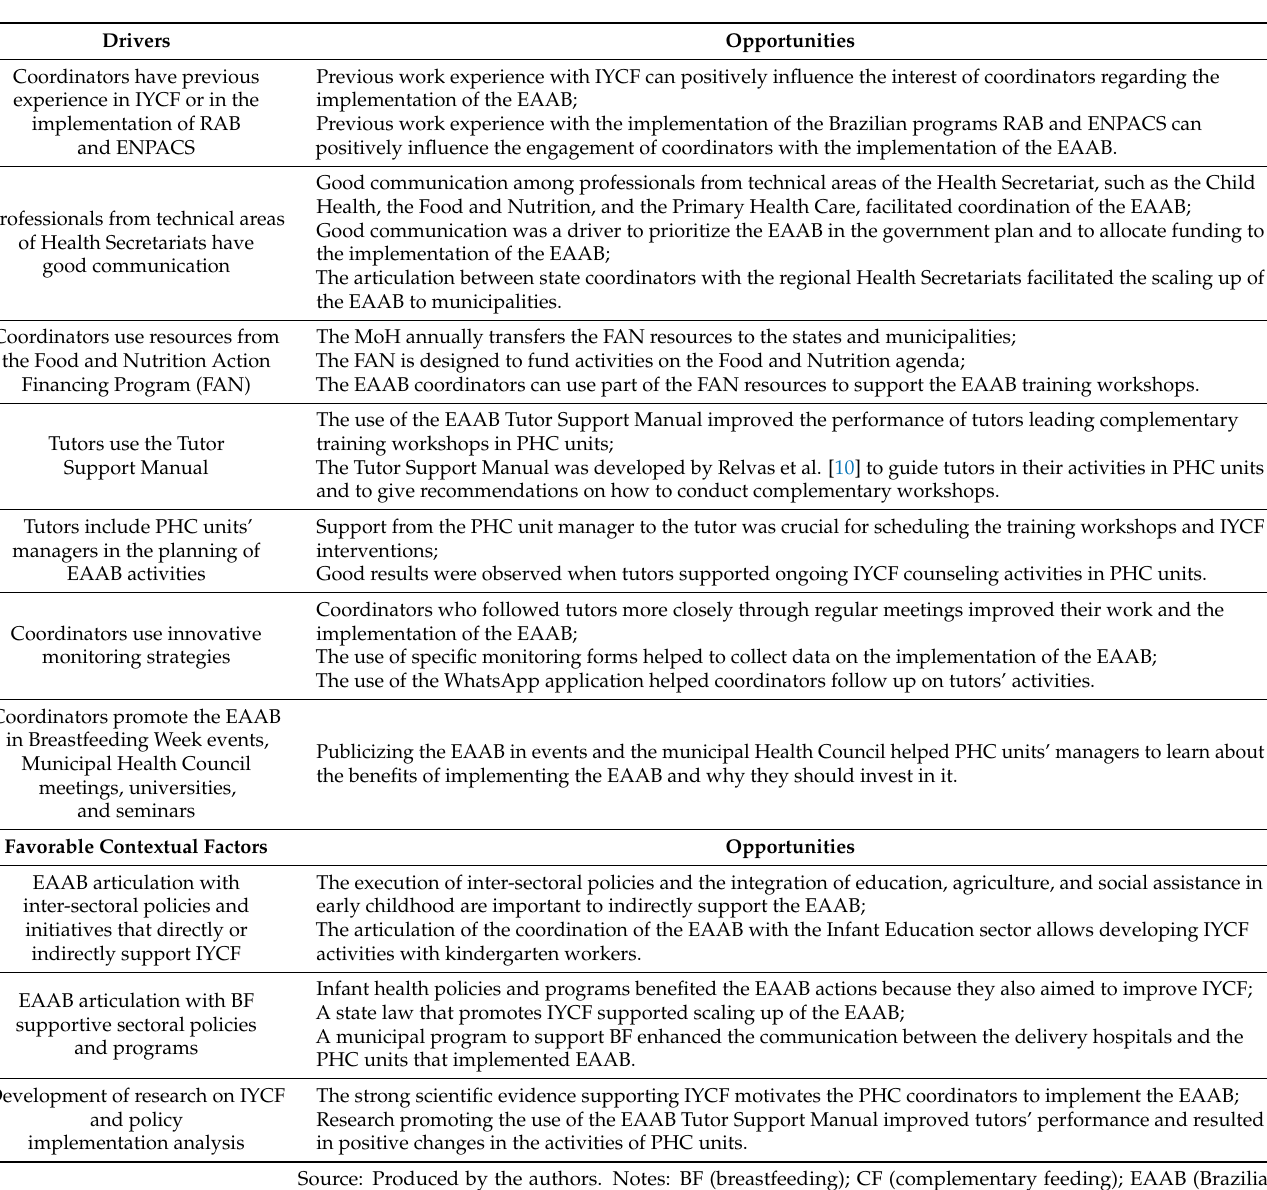
Table 3. Drivers and Favorable Contextual Factors based on the facilitators in the implementation of the